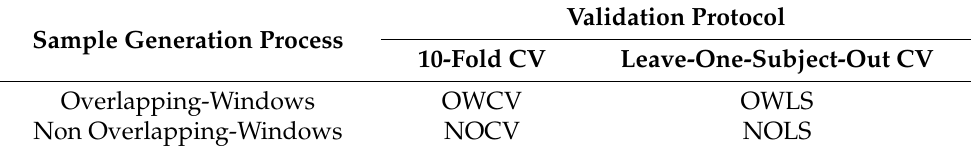
Table 2. Combination between sample generation processes and validation process used in this